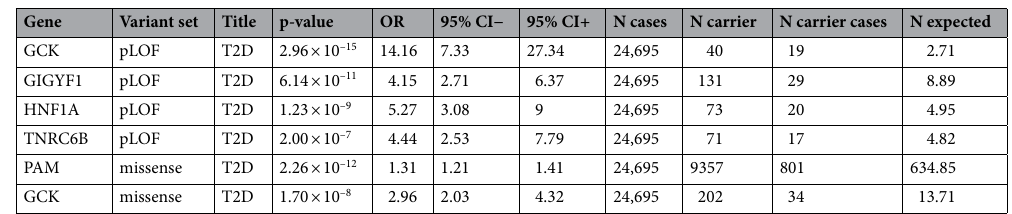
Table 2. Gene-level associations with T2D diagnosis. pLOF or damaging missense variants (CADD score ≥ 25) were aggregated per gene. OR odds ratio, CI confidence interval.